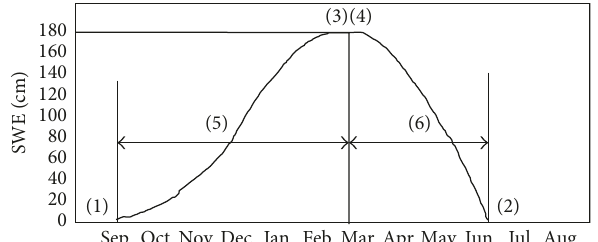
Figure 2: Sketch of the basic snow metrics based on the daily SWE curve. Metrics (1) and (2) mark the days of the initial snow ac- cumulation and snow disappearance, respectively. Metrics (3) and (4) mark the peak SWE date and peak SWE value, respectively. Metrics (5) and (6) indicate the length of the accumulation and melt seasons,